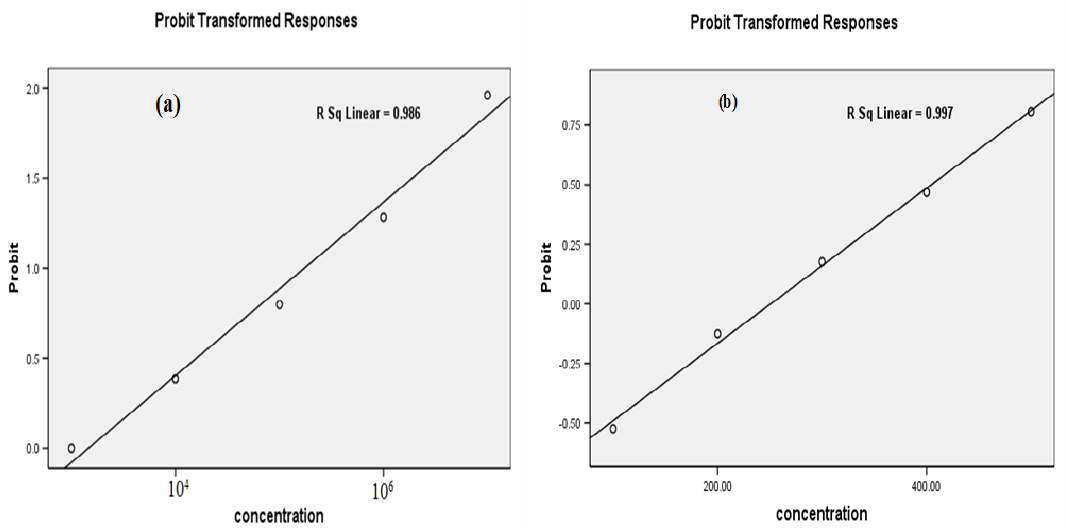
Figure 6. ( a,b )The probability analysis of mortality of C. pipiens mosquito larvae by fungus, M. brunneum and Co 3 O 4